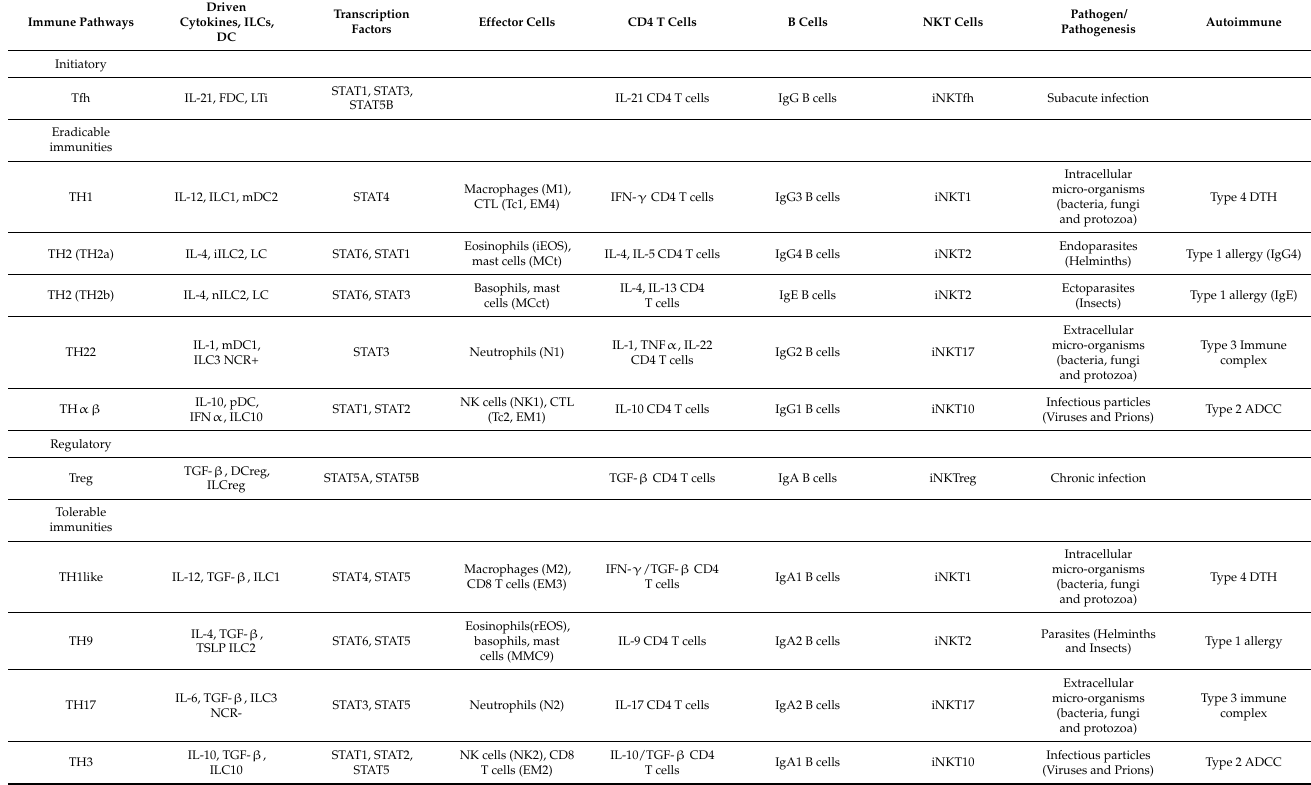
Table 1. Summary of host immunological pathways and their relations to pathogens and hypersensi- tivities. Reprinted from Ref.